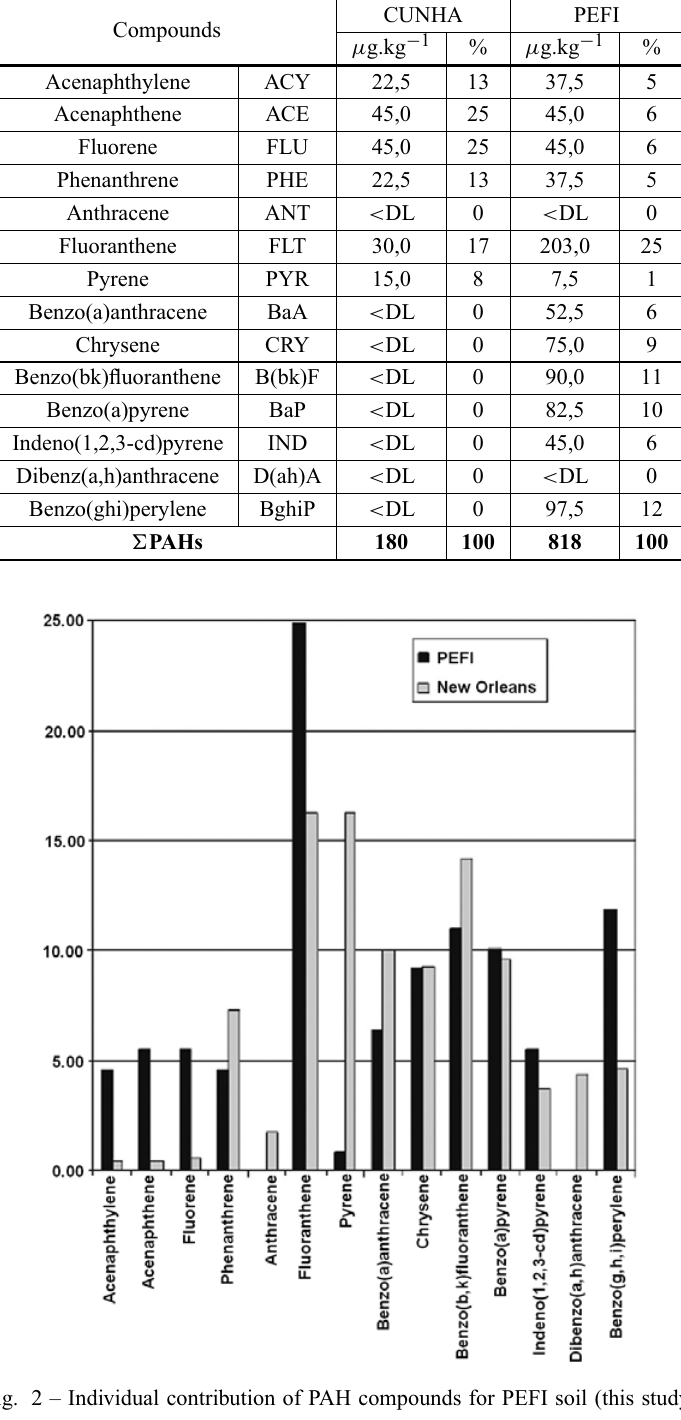
(cid:1) (cid:2) in µ g.kg –1 in Cunha and PEFI soils inte-